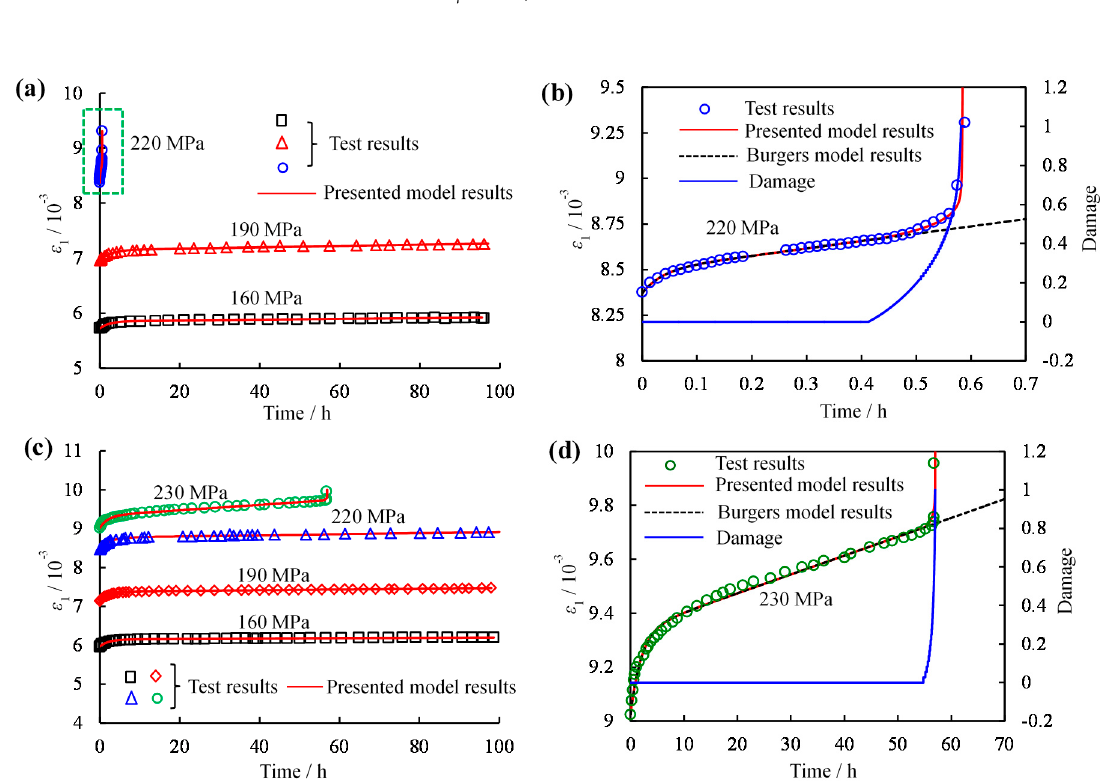
Figure 13. Comparison between the modeling and experimental results under confining of 25 MPa: ( a ) 25 ◦ C; ( b ) partial enlarged for σ 1 − σ 3 = 220 MPa; ( c ) 300 ◦ C; ( d ) partial enlarged for σ 1 − σ 3 = 230